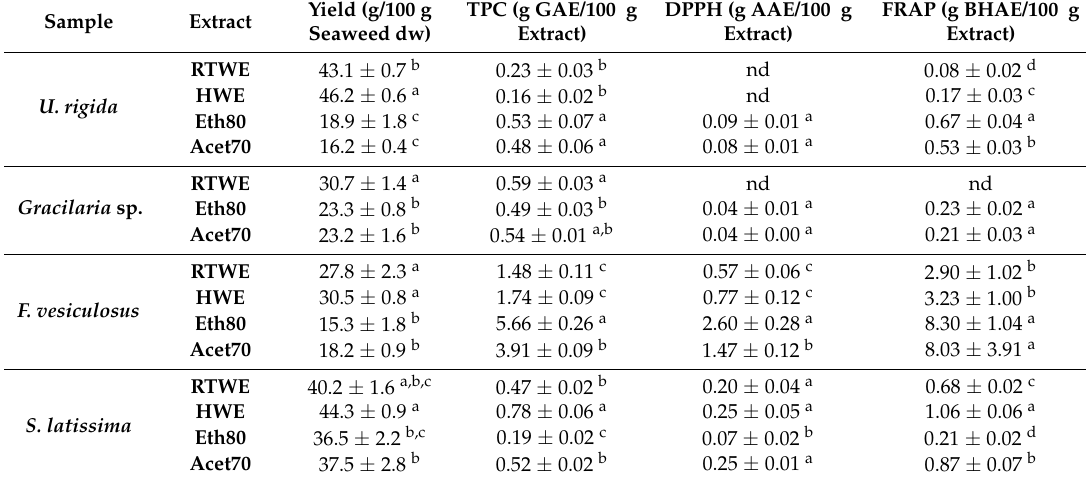
Table 3. Total phenolic content (TPC), antioxidant activity measured by 2,2-diphenyl-1-picrylhydrazyl (DPPH) and ferric reducing antioxidant power (FRAP) methods.